Question: Which visualization type does this figure use?
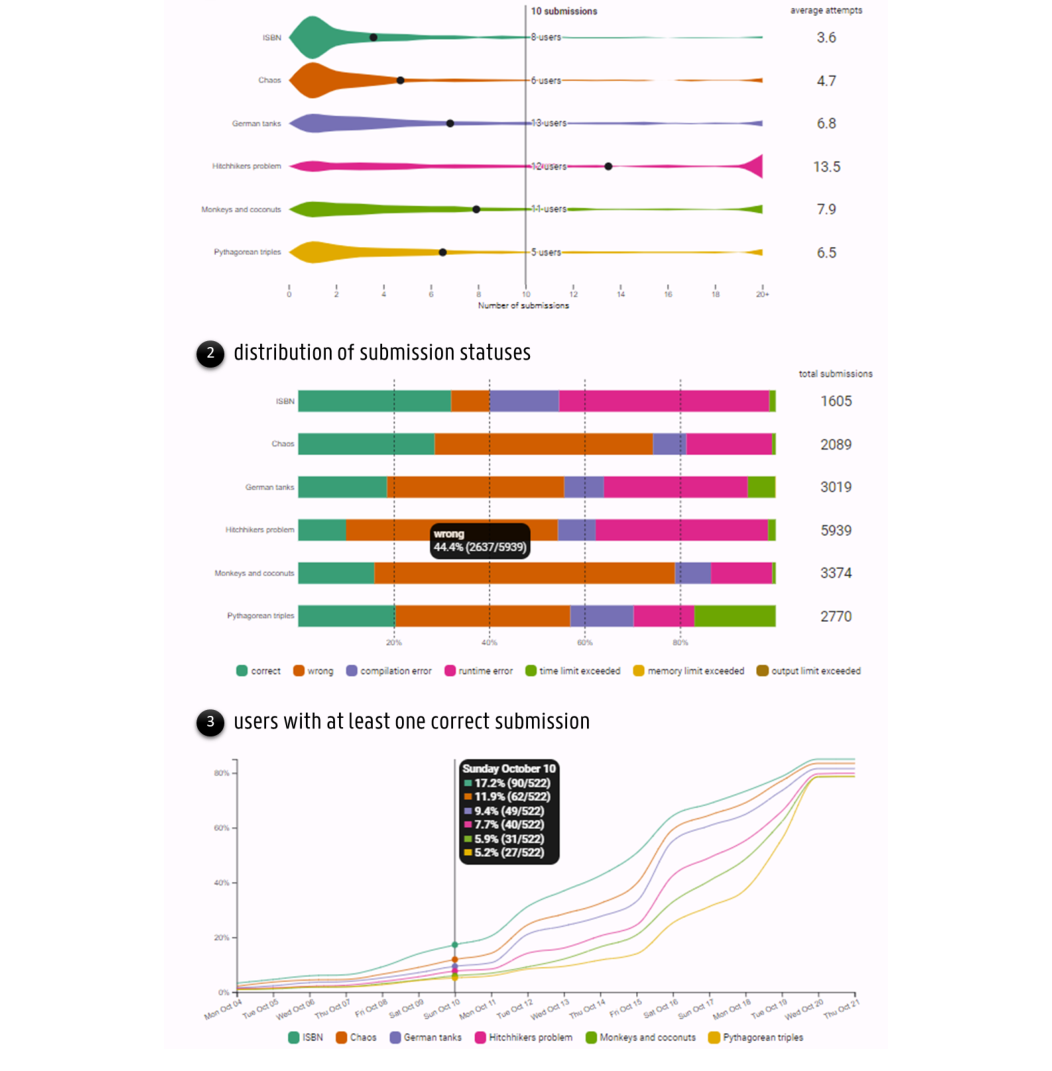
Answer: line